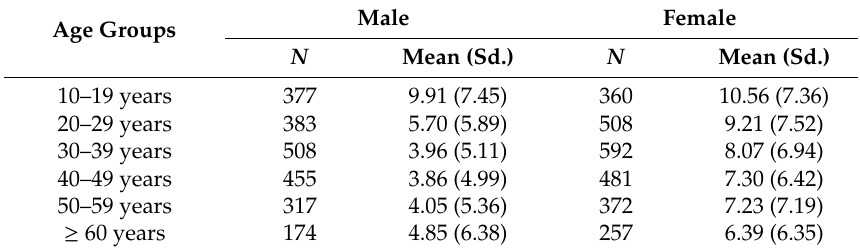
Table 3. Share of caloric intake from food and beverages with added sugars, by gender and age